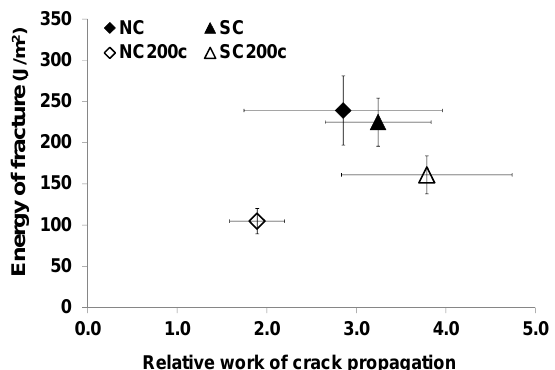
Figure 9. Energy of fracture versus relative work of crack propagation of extruded cellulosic fiber cement non ‐ carbonated (NC) and submitted to supercritical CO 2 (SC), before and after exposure to 200 soaking and drying cycles (200c) (Based on [81]).